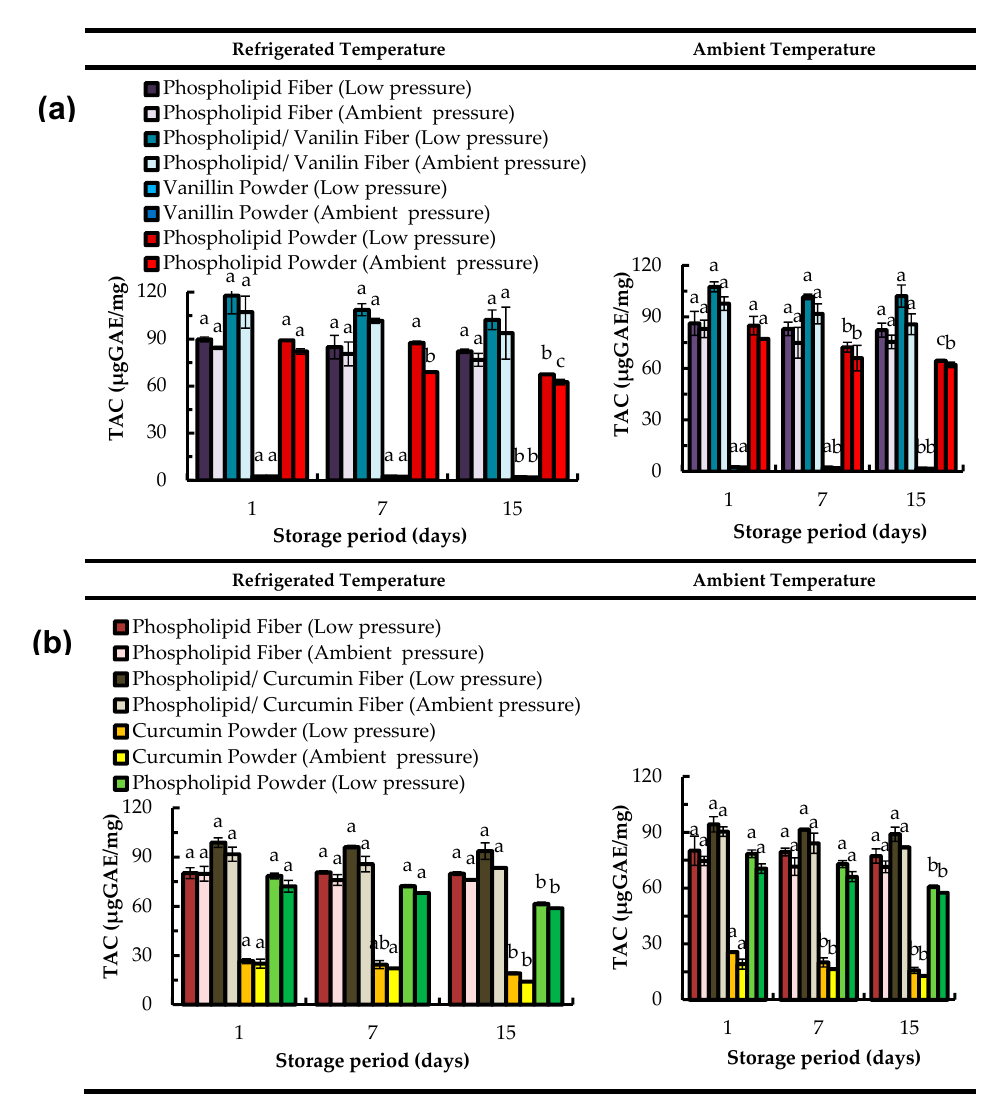
Figure 3. Total antioxidant capacity (TAC) over time of electropsun phospholipid fibers prepared using limonene (top graphs ( a )) and isooctane (bottom graphs ( b )) as solvent; Data are represented as mean ± SD [N = 3]; a–c: significant difference at p ≤ 0.05 in terms of total antioxidant capacity of each storage condition during storage time.